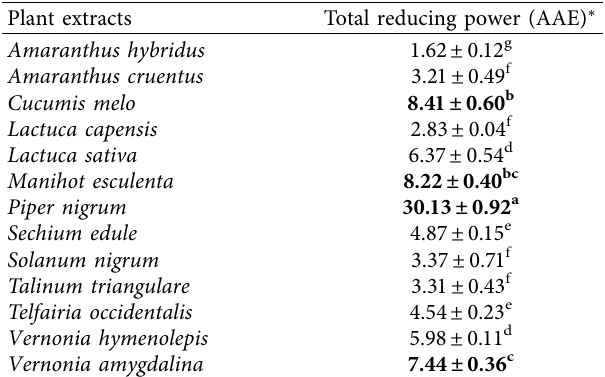
Table 2: Total reducing power of the methanol extracts of thirteen antibacterial edible plants.